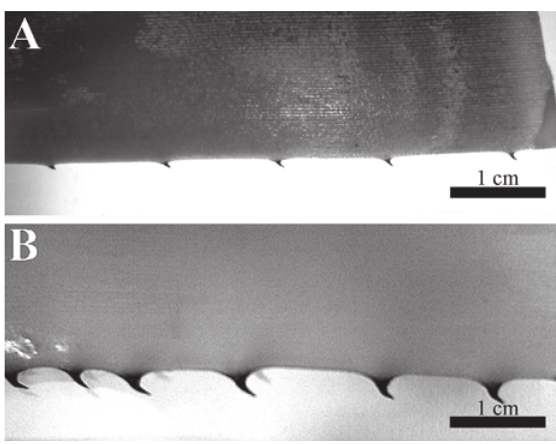
Figure 2 - Leaf thorns of shade (A) and sun (B) plants.